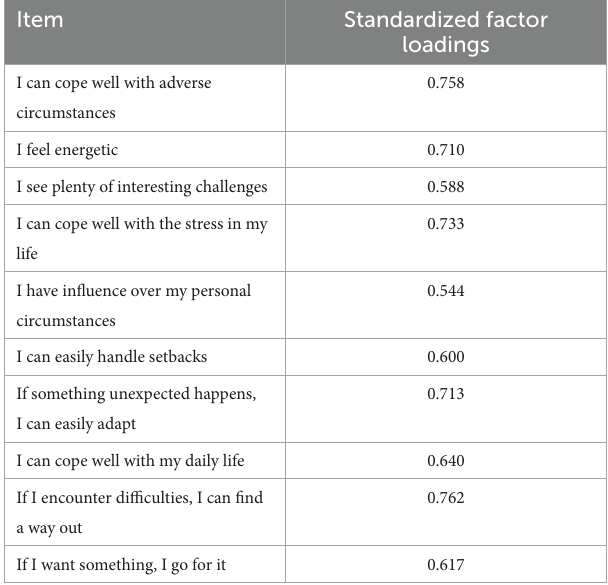
TABLE 3 Completely standardized factor loadings for the 10 item one- factor solution of the